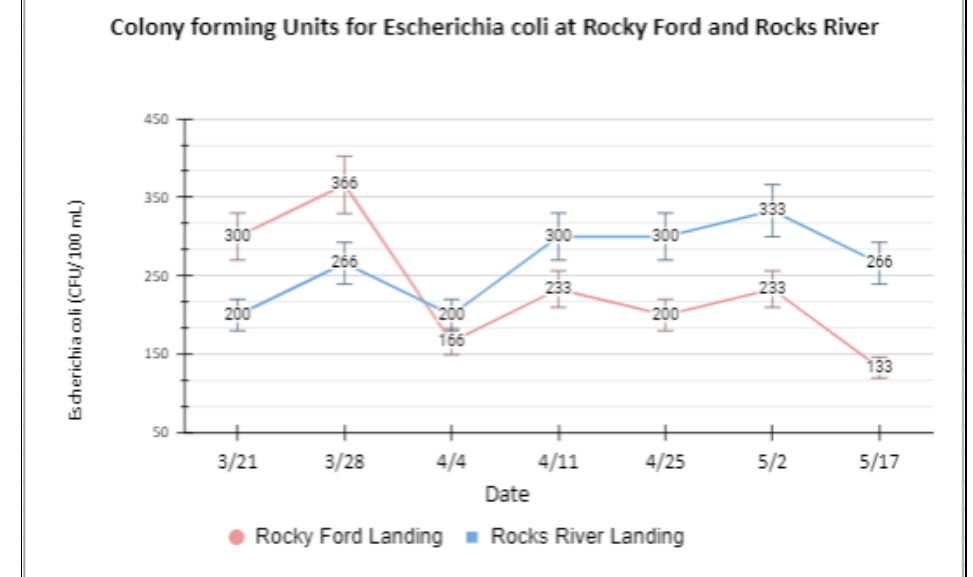
Figure 12. Water Quality — Escherichia coli Measurements from March – May 2022. At Rocky Ford Landing and Rocks River Landing, the pH, DO, and conductivity levels averaged at 7, 6.16 ± 0.35 mg/L, and 143 ± 33.6 µS/cm and for Rocks River at 6.5 ± 0.4, 6.4 ± 0.82 mg/L, and 80 ± 44.54 µS/cm, respectively. Rocky Ford had the lowest E. coli counts averaging at 193.2 ± 79.42 CFU/100 mL, while Rocks River Landing had a total E. coli count average of 233 ± 50.9 CFU/100 mL. At Little Lotts Creek, water samples were